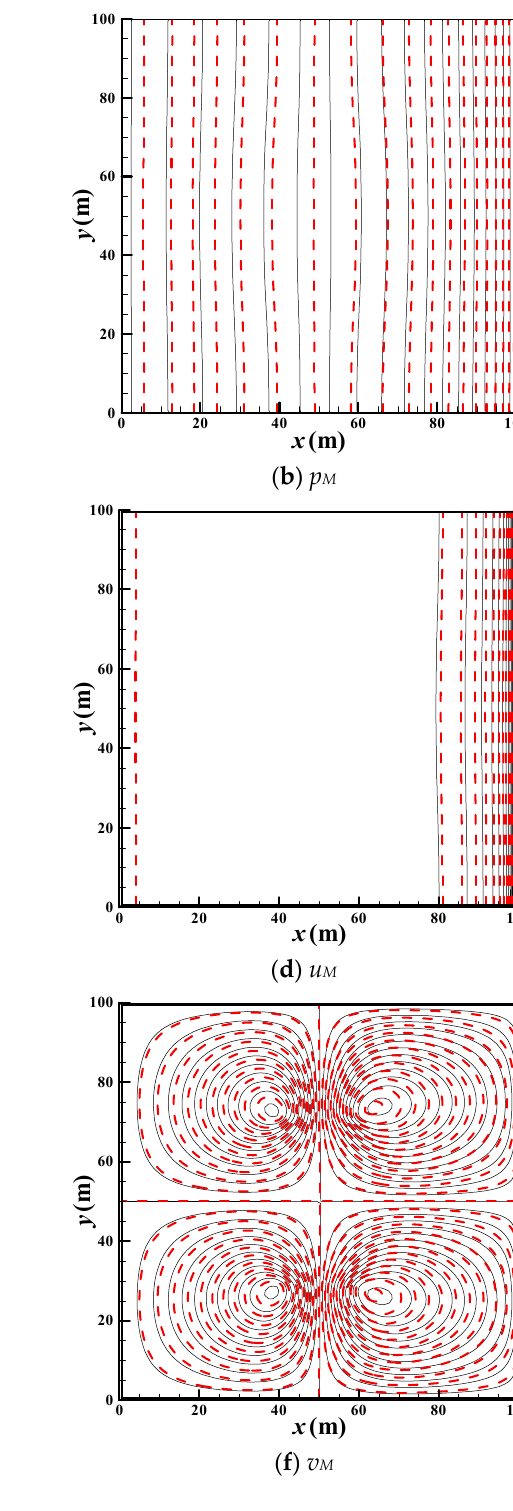
Figure 9. Flow field comparison for matrix and fracture at 365 days: black solid line-FDM; red dashed line-POD ( 0.83% ε = F , 1.02% ε = M ).